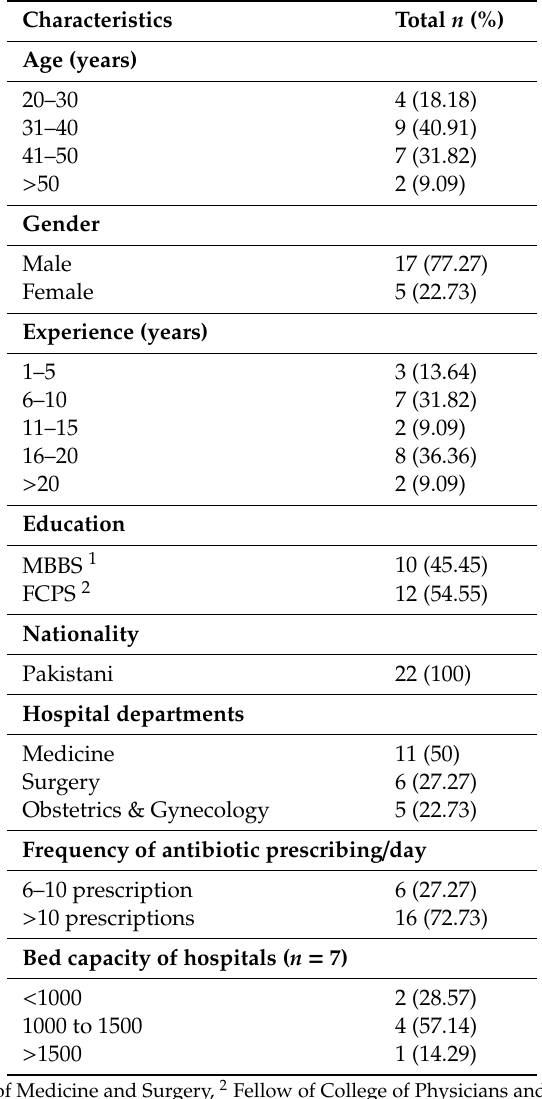
Table 1. Demographic information of participants ( n = 22) and hospital characteristics ( n =